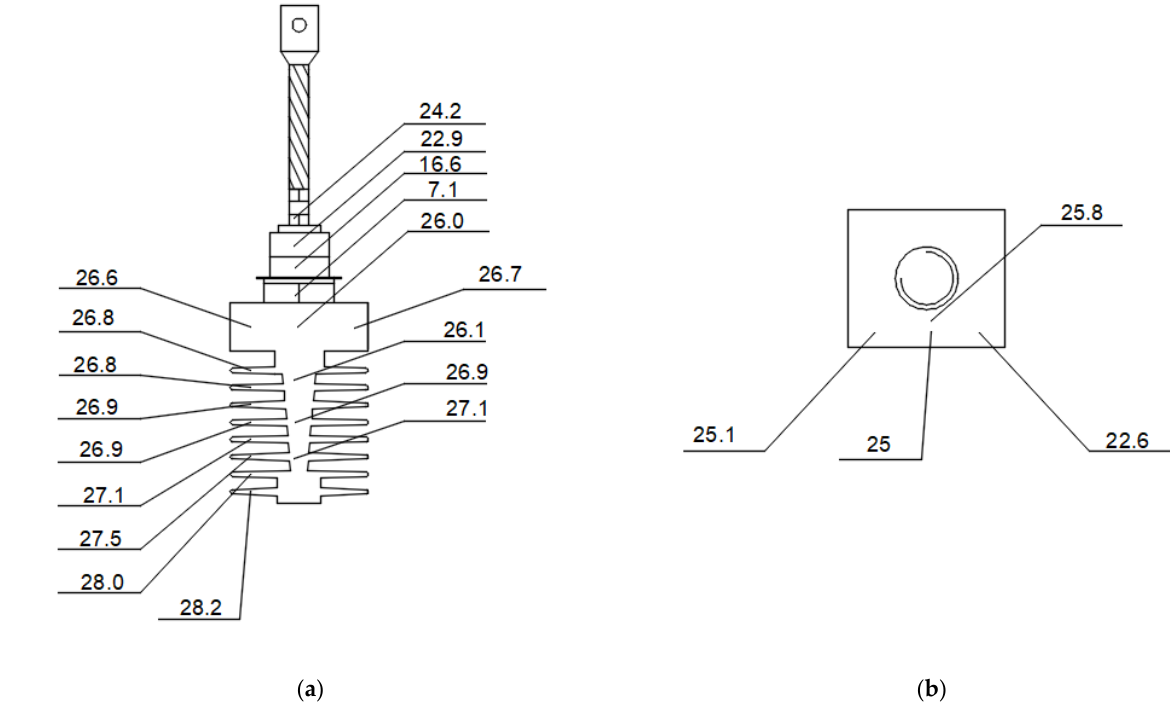
Figure 19. Differences ( T j − T s ) between the junction temperature ( T j ) and the surface temperatures ( T S ) (from Tables 6 and 7) at points presented in Figure 2 for a power of Pj = 49.61 W: ( a ) side view; ( b ) top view.